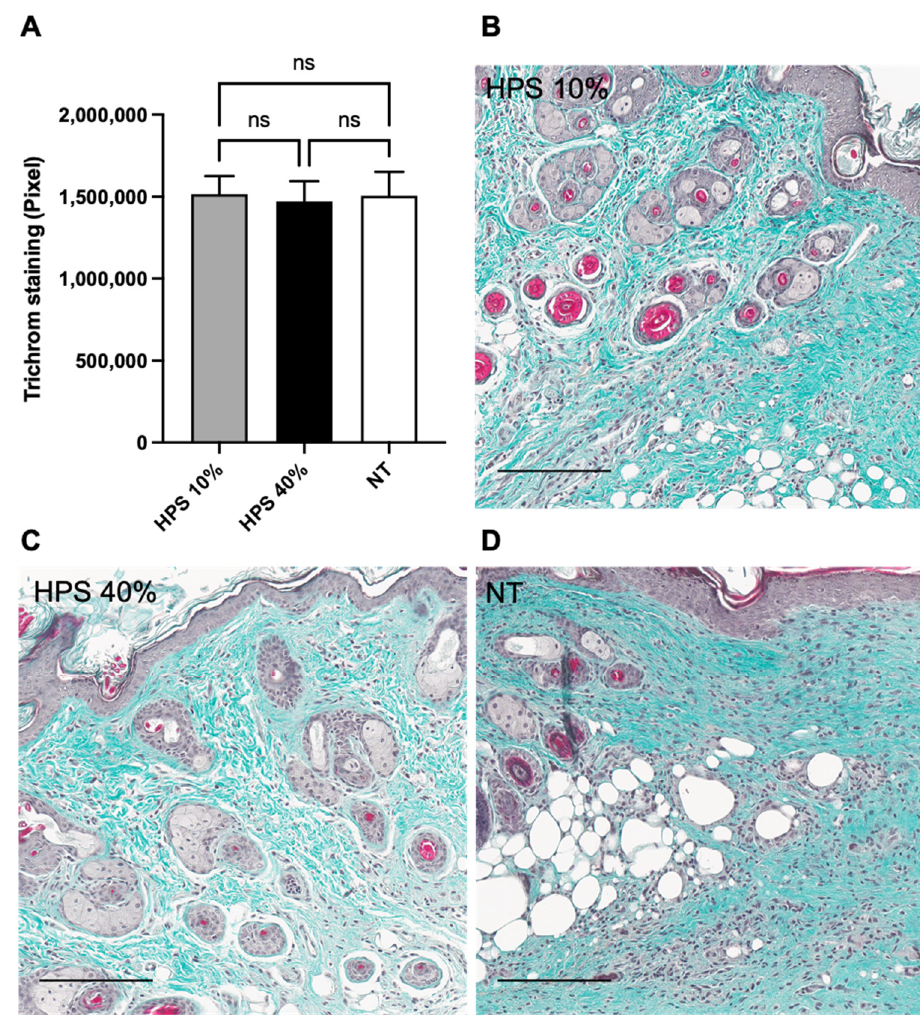
Figure 5. Masson-Goldner-Trichrom staining. ( A ) Quantitative measurement of collagen fiber deposits in the subdermal layers of HPS-10% ( n = 14) and 40% ( n = 14) treated murine wounds vs. no treatment (NT) ( n = 10) on POD 15 by color segmentation of collagen-staining, calculated as pixels. There was no overproduction of collagen in HPS-treated groups compared to NT. Data are means ± SEM. Ns = non-significant. One-way ANOVA with Tukey’s post-hoc test. ( B – D ) Representative high-power fields of Masson-Goldner-Trichrom staining of HPS-10%, HPS-40%-treated wounds and NT wounds. Scale bar = 200 µm.